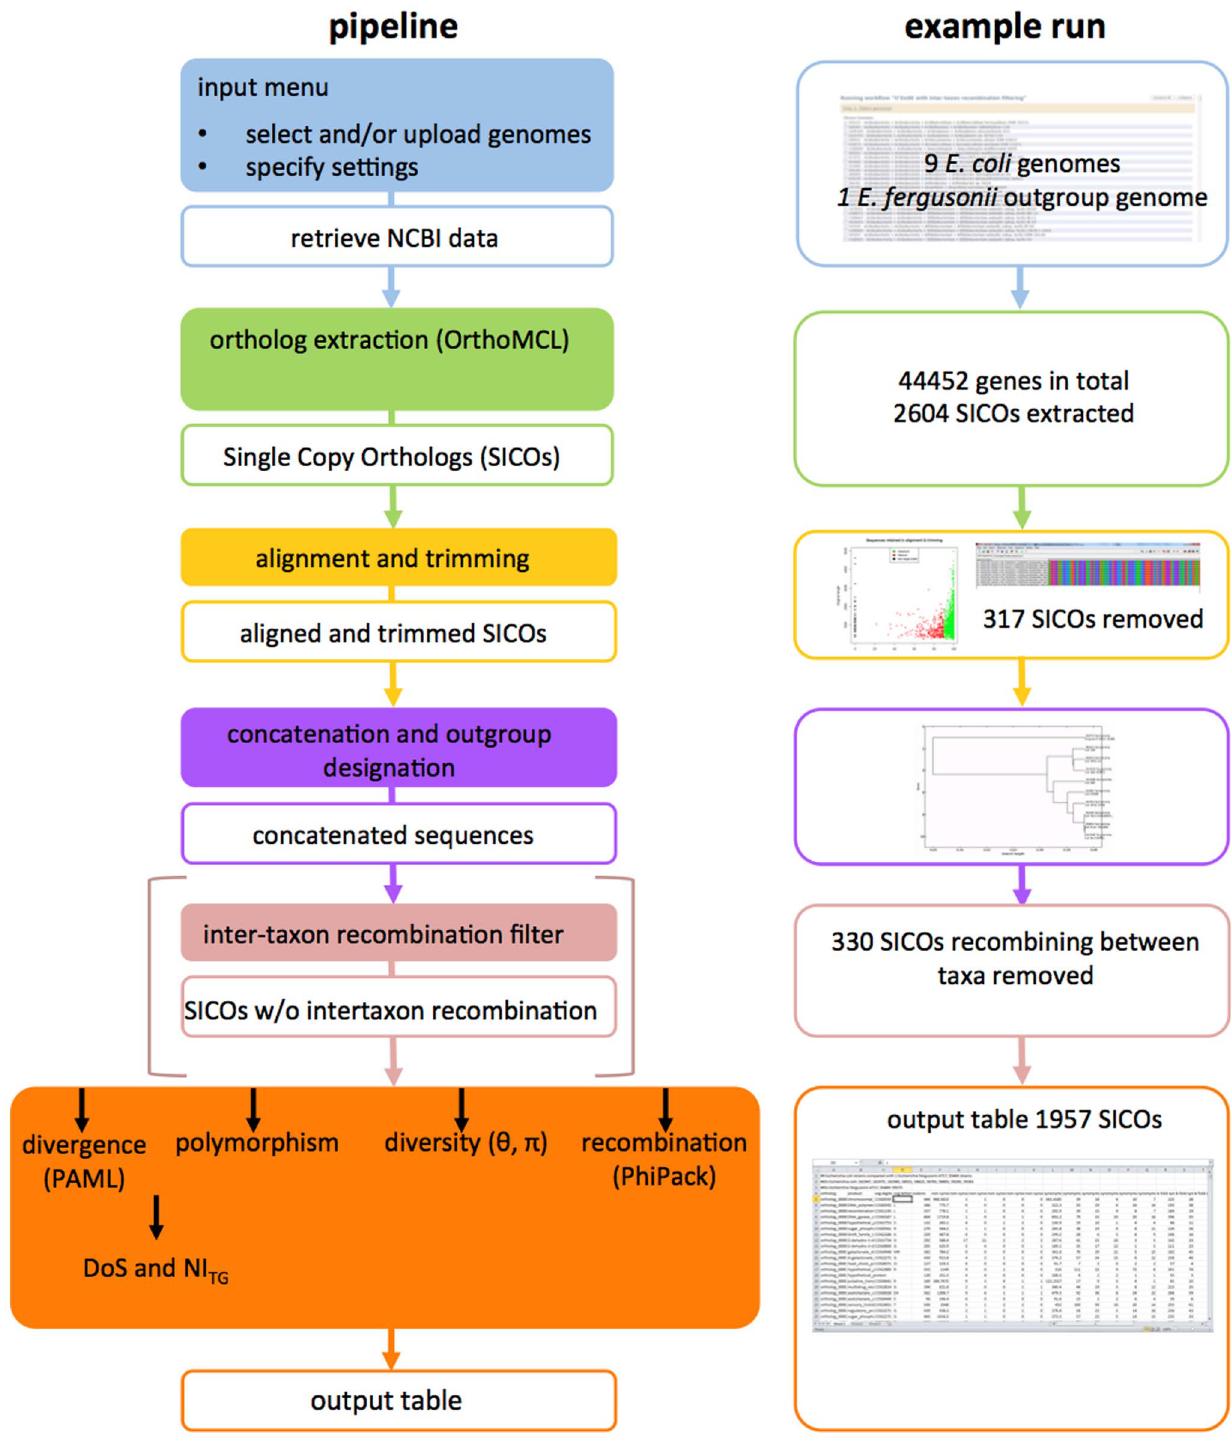
Figure 1. Schematic representation of the ODoSE workflow.